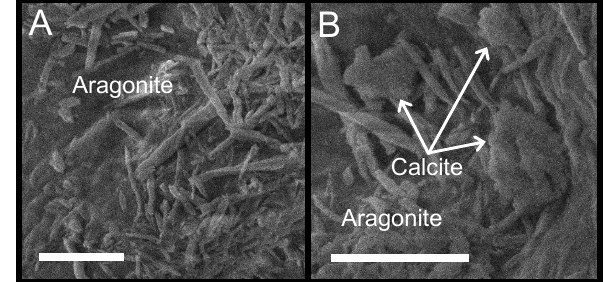
Fig. 6. Back-scatter electron images showing the distribution of the aragonite needles and calcite rhombs (indicated by arrows) pre- cipitated within the interutricular space of segments comprising the thalli of Udotea flabellum algae reared in experimental seawaters with Mg/Ca=5.2 and [Ca 2 + ]=10.2mmolkg-SW − 1 (aragonite sea- water, A ) and Mg/Ca=1.0 and [Ca 2 + ]=31.6mmolkg-SW − 1 (cal- cite seawater, B ). Note that calcite is only evident within algae grown in the experimental calcite seawater. Scale bars are 1µm (modified from Ries, 2005b, 2006a).